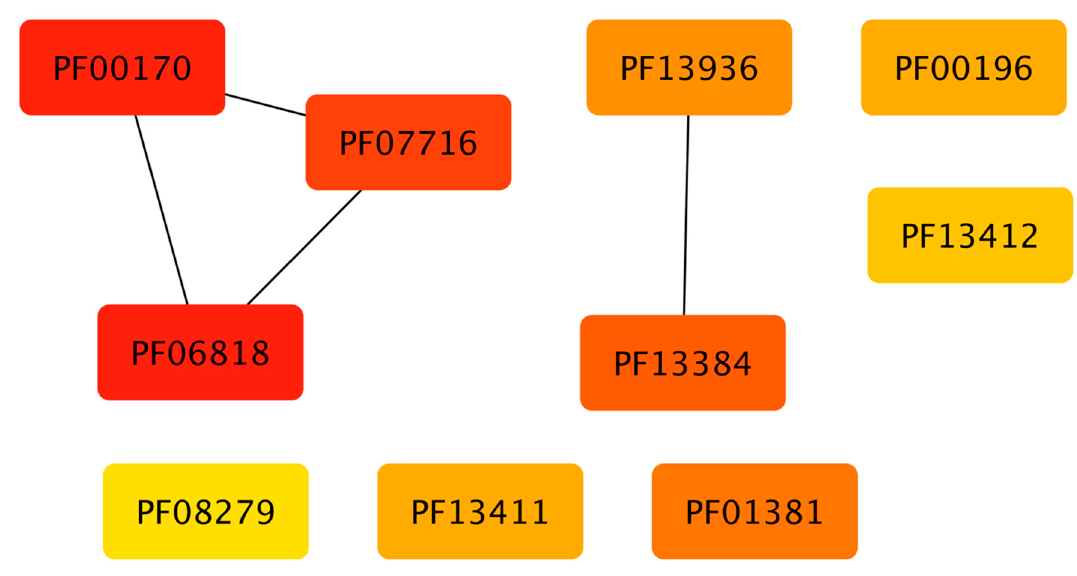
Figure 5. Top 10 families of TFs identified by MCC(Maximal Clique Centrality). Each box represents a protein family (see Section 3.5) and lines between boxes indicate that some families share additional domains.